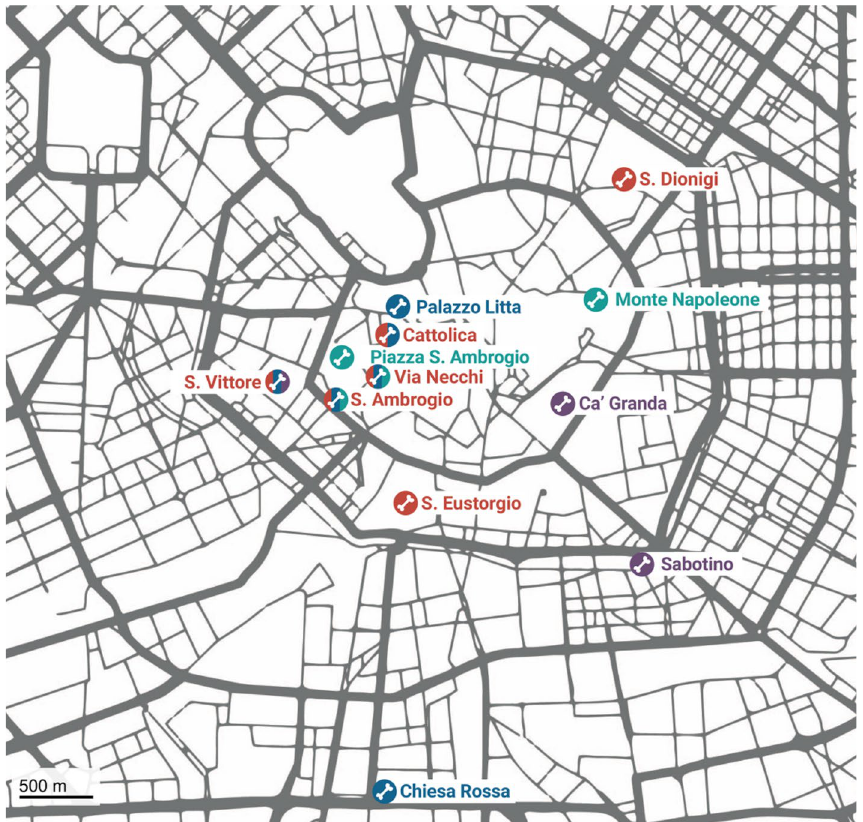
Figure 1. Map of Milan with the different archeological sites selected according to their historical period (red: Roman era, blue: Early Middle Ages, green: Late Middle Ages, purple: Modern era; contemporary cemeteries from the CAL Milano Cemetery Skeletal Collection are located further away from the city